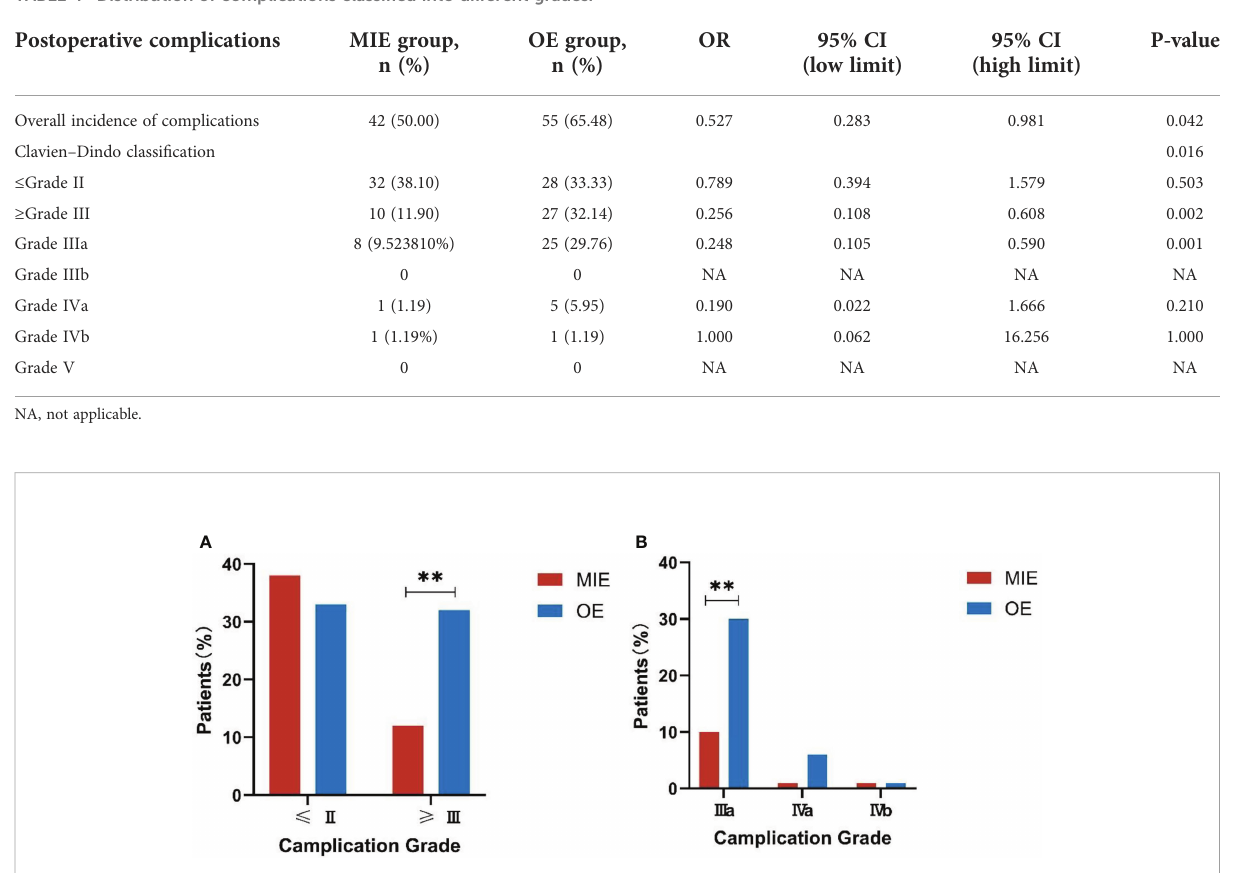
TABLE 4 Distribution of complications classi fi ed into different grades.